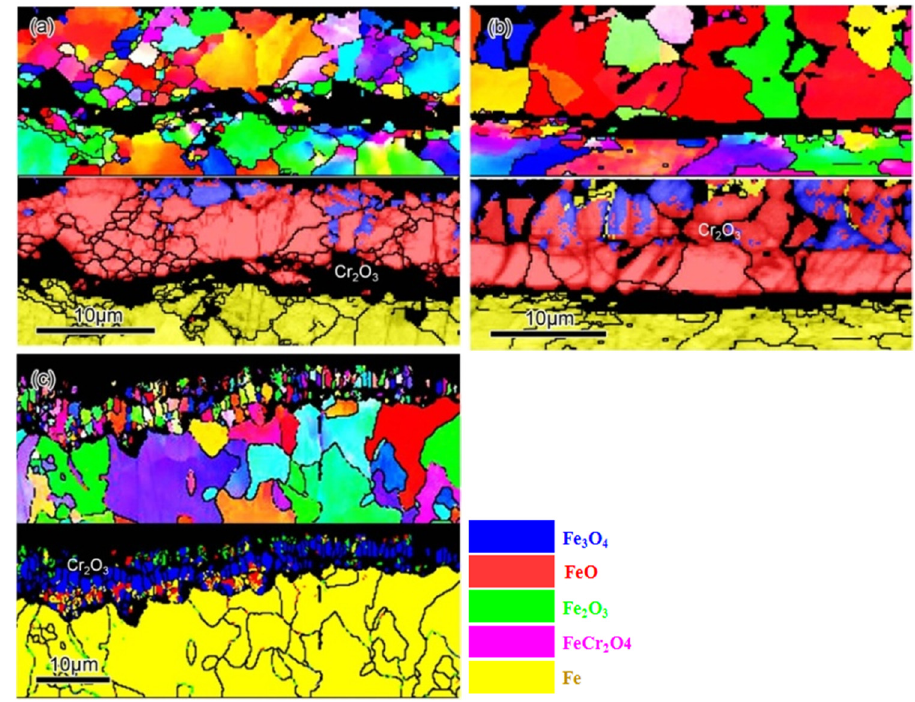
Figure 8: EBSD analysis of the oxide sheet of the steel sample at: ( a ) 800°C, ( b ) 900°C, and ( c )